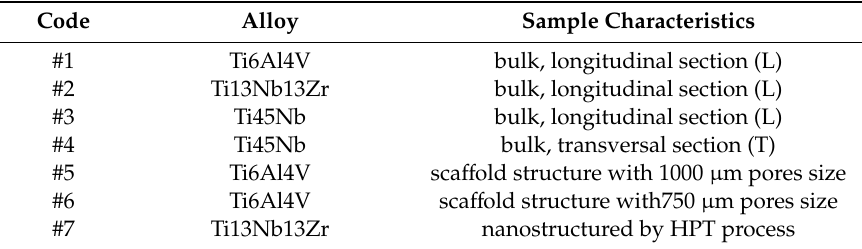
Table 2. Samples’ codification. HPT: high pressure torsion.